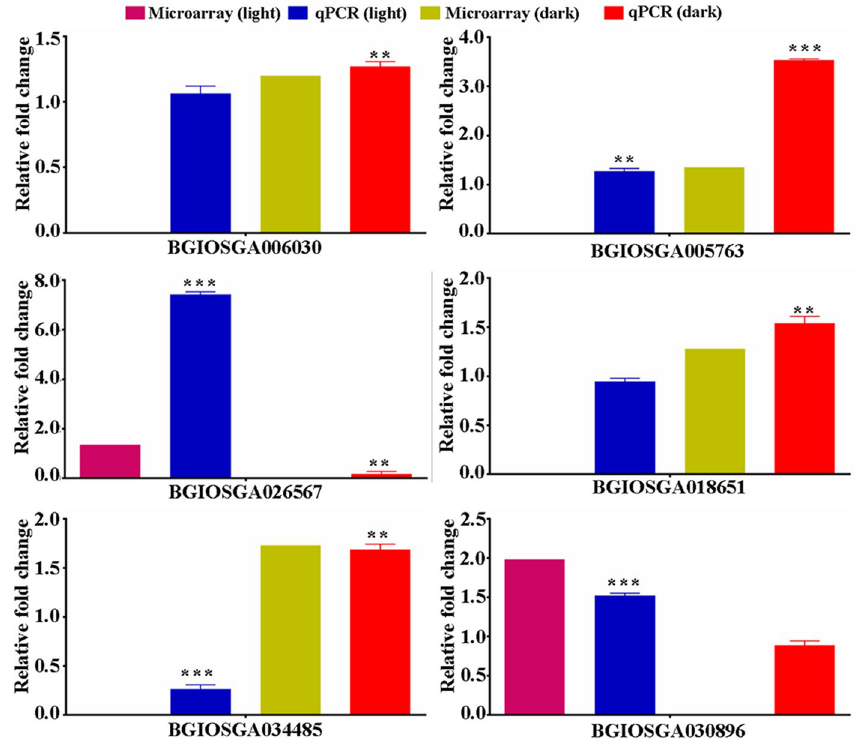
Figure 4. qRT-PCR validation of nitrate-responsive genes identified in light and dark conditions. Total RNA was isolated from control (H 2 O) and nitrate-treated leaves of 10 days old light-grown and etiolated rice seedlings. Relative transcript abundance was calculated by comparative Ct method using actin as a reference gene for data normalization. The data represent the mean ± SE of three technical replicates. Final relative fold change values (qPCR) of DEGs and their corresponding values obtained in microarray experiment were plotted for parallel comparison of DEG trends in qPCR and microarray experiments. To avoid additional bars and better clarity of the results, control value (H 2 O) obtained in qPCR were not included in the image. However, the statistical analyses were performed between control (H 2 O) and nitrate treated value (comparative Ct method) obtained by qPCR. Statistical unpaired T test analyses [control (H 2 O) vs. nitrate] were performed in the GraphPad Prism 6 software using technical replicates (**p value < 0.01, ***p value < 0.001). The experiments were performed with three independent biological replicates. MYB family transcription factors (BGIOSGA006030, BGIOSGA018651); universal stress protein domain containing protein (BGIOSGA005763); calcium-dependent protein kinase (BGIOSGA026567); efflux transporter of nicotianamine 1 (BGIOSGA034485); bHLH120